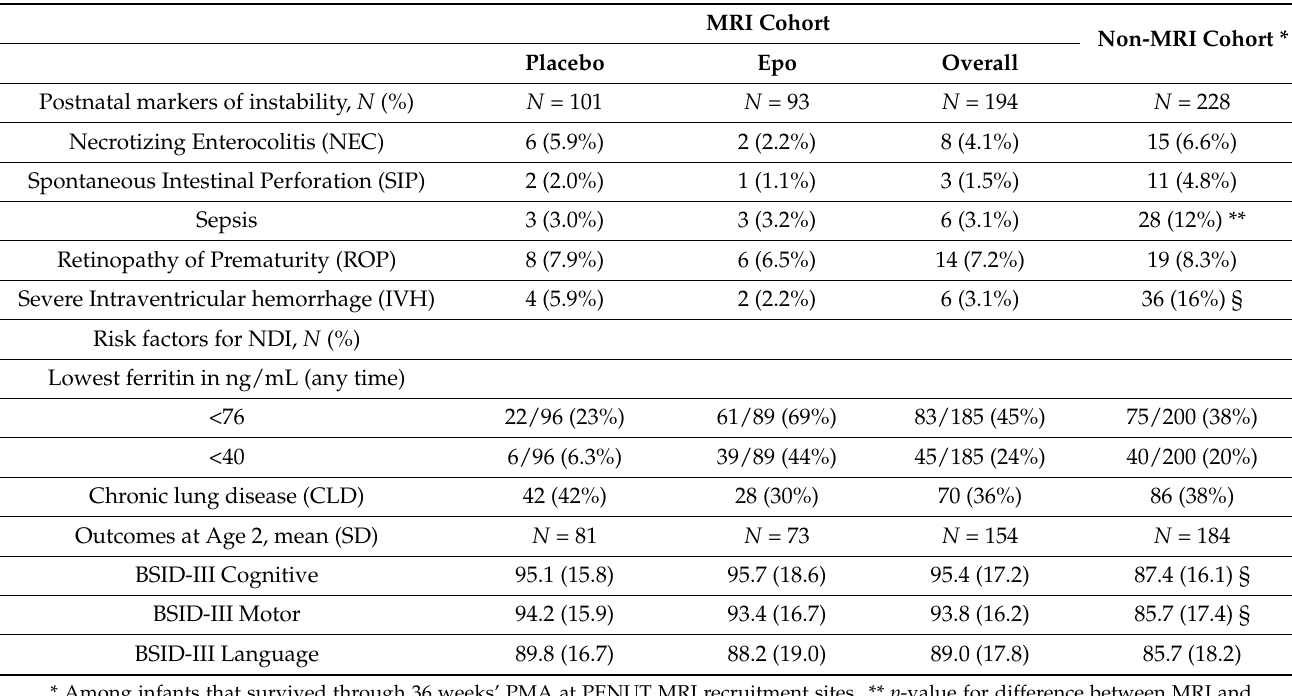
Table 2. Complications and comorbidities between birth and 36 weeks’ PMA, and outcomes at age 2. MRI Cohort Non-MRI Cohort * Placebo